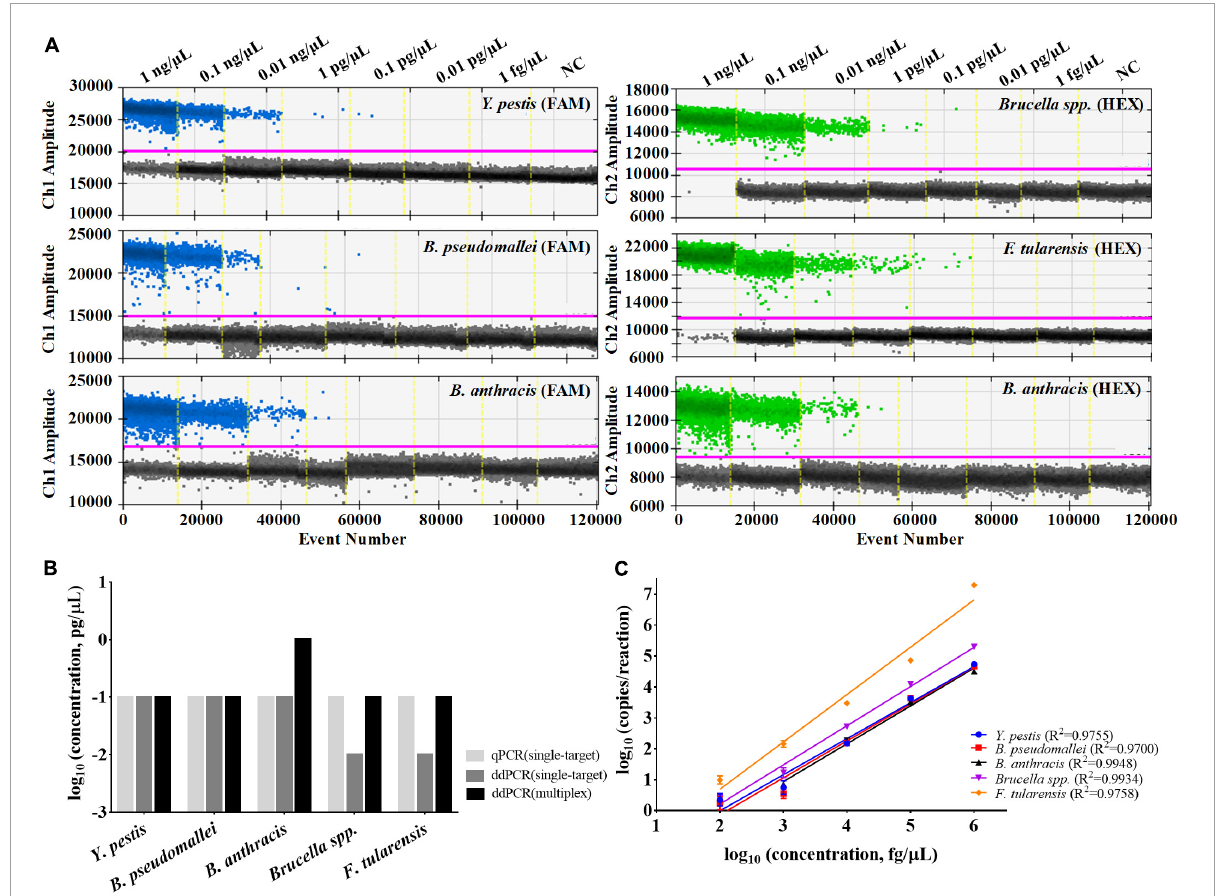
FIGURE4 Performances of the multiplex ddPCR assay. (A) Detection results of the target DNA with concentrations from 1 fg/ µ L to 1 ng/ µ L by the multiplex assay. (B) Comparisons of the LODs between single-target qPCR, single-target ddPCR and the multiplex ddPCR method. (C) Quantification linearity of the target DNA by multiplex ddPCR. The purple line indicates the threshold for positive signals. NC refers to the negative control (DNAase-free